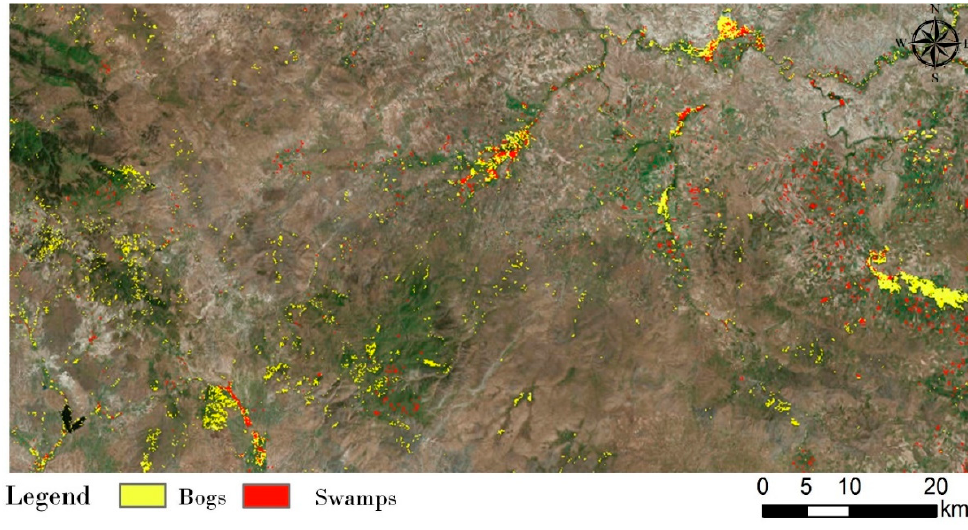
Figure 3. Results of Dataset